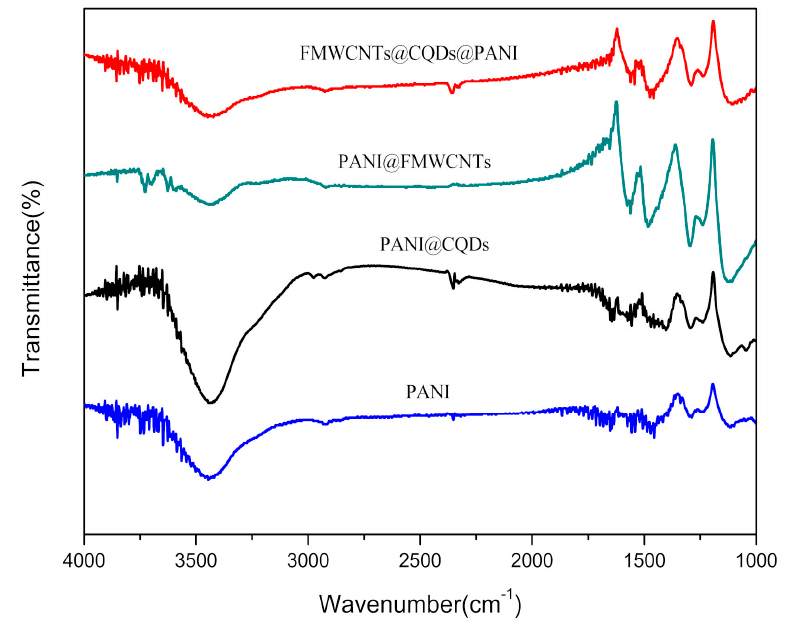
Figure 1. FTIR spectra of FMWCNTs @ CQDs @ PANI, PANI @ FMWCNTs, PANI @ CQDs and PANI.